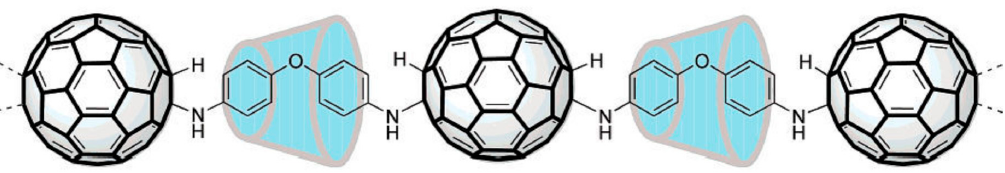
Figure 2. Water-soluble main-chain fullerene polymer with supramolecular cyclodextrin shielding of linking groups [10].